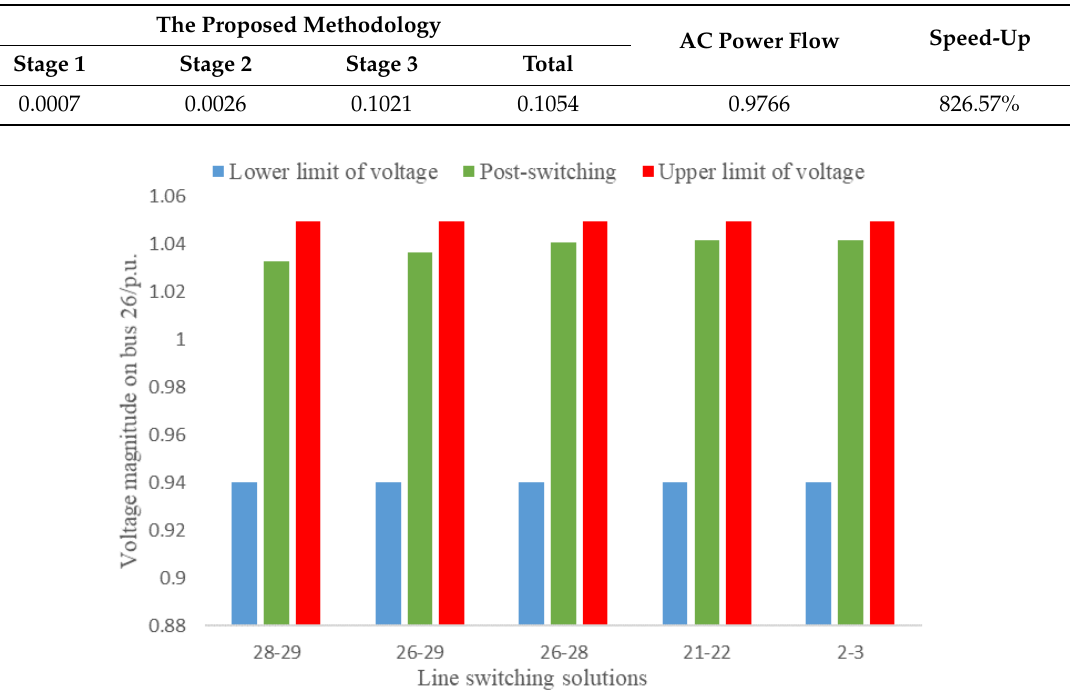
Figure 8. The voltage of bus 26 for the pre-switching and post-switching systems.